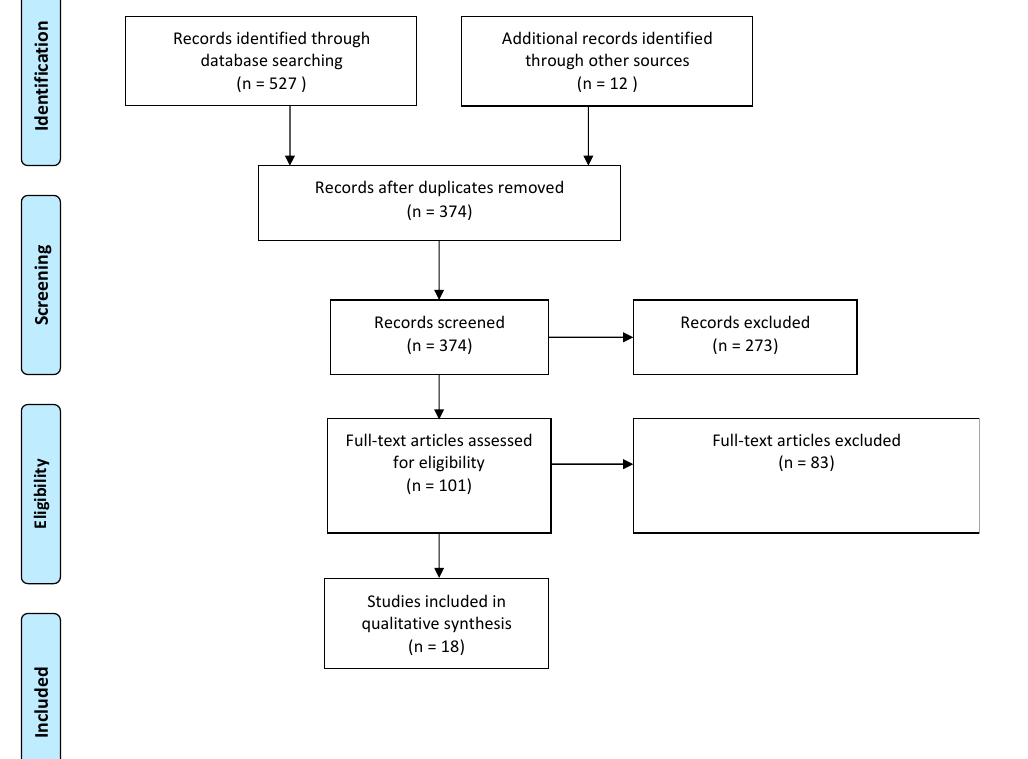
Figure 1. PRISMA diagram of included studies.